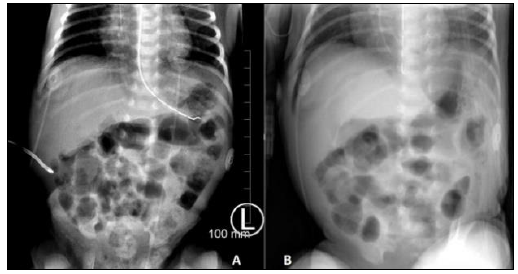
Figure 1: A) Initial plain abdominal radiograph demonstrating pneumatosis intestinalis. B) Follow-up plain abdominal radiograph demonstrating intra-peritoneal, extra-luminal gas.